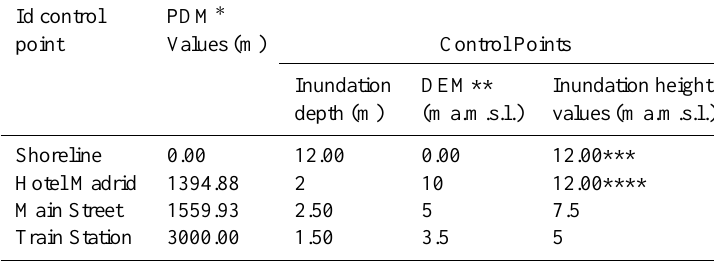
Table 3. Control points list and corresponding values of digital terrain